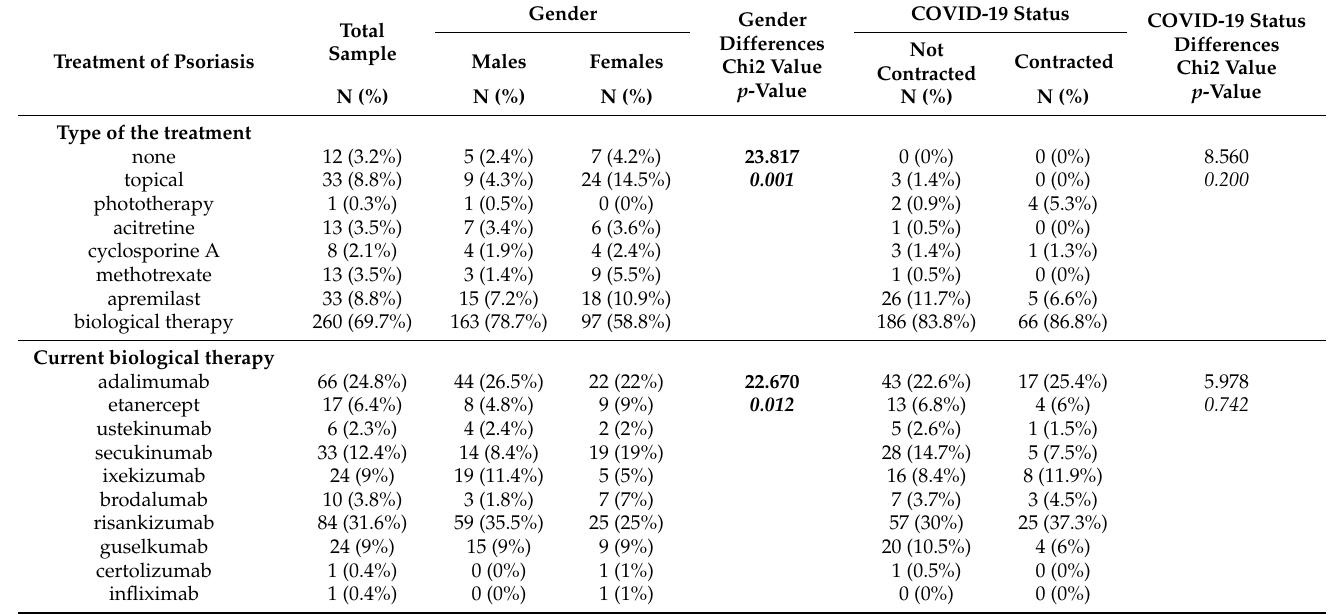
Table 5. Treatment of psoriasis and biological therapy categories (numbers and relative prevalence in %) presented for the total sample and stratified according to gender and COVID-19 contraction status, differences tested with Pearson’s chi-squared test. Gender Gender COVID-19 Status COVID-19 Status Total Differences Differences Sample -ValueTreatment of Psoriasis Chi2 Value Chi2 Value p -Value p